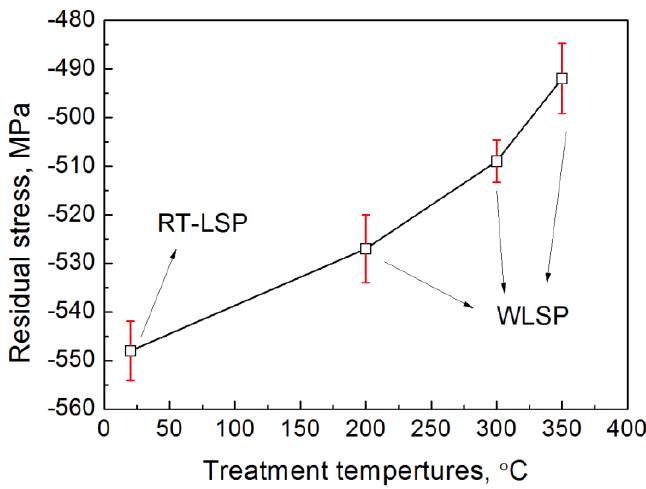
Figure 8. Residual stress on the surface of RT-LSPed and WLSPed samples.